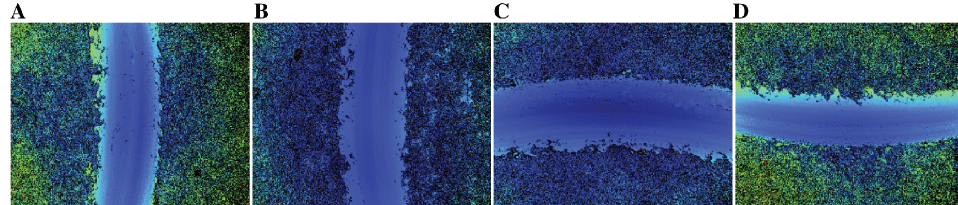
Figure 4: Depth profile ( μ m) and width (mm) of the wear track taken by the optical